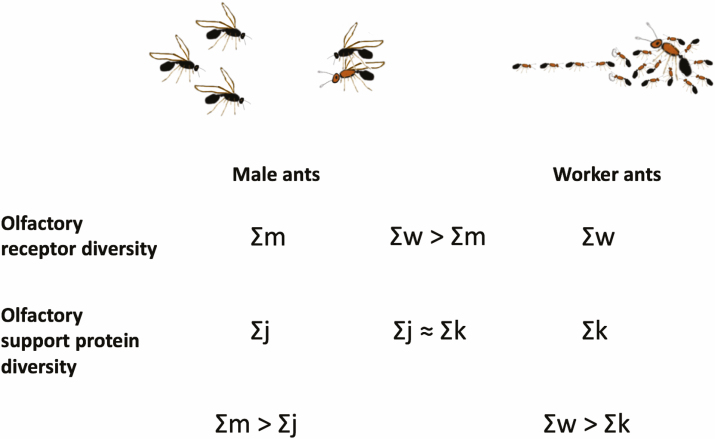
The diversity of olfactory support proteins is about the same in worker and male fire ants, in contrast to the diversity of olfactory receptors, which is much higher in workers.